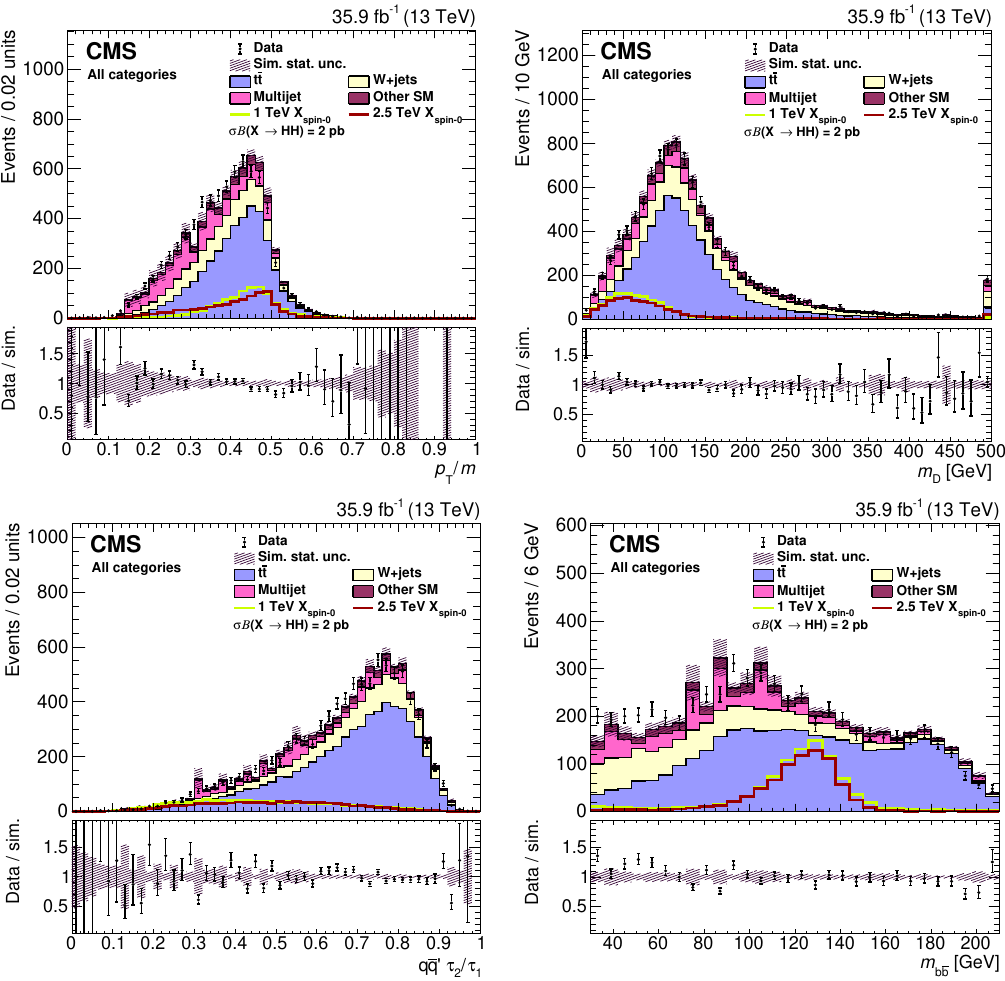
Figure 1 . Pre-modeling and pre-(cid:12)t distributions of the discriminating variables, which are de- scribed in the text, are shown for data (points) and SM processes ((cid:12)lled histograms) as predicted directly from simulation. The statistical uncertainty of the simulated sample is shown as the hatched band. The solid lines correspond to spin-0 signals for m of 1 and 2.5 TeV. The product of the X cross section and branching fraction to two Higgs bosons is set to 2 pb for both signal models. The lower panels show the ratio of the data to the sum of all background